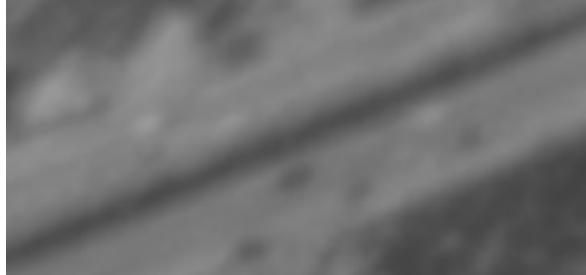
Figure 2: Pavement background of the cartoon part of the TV-L1 texture decomposition